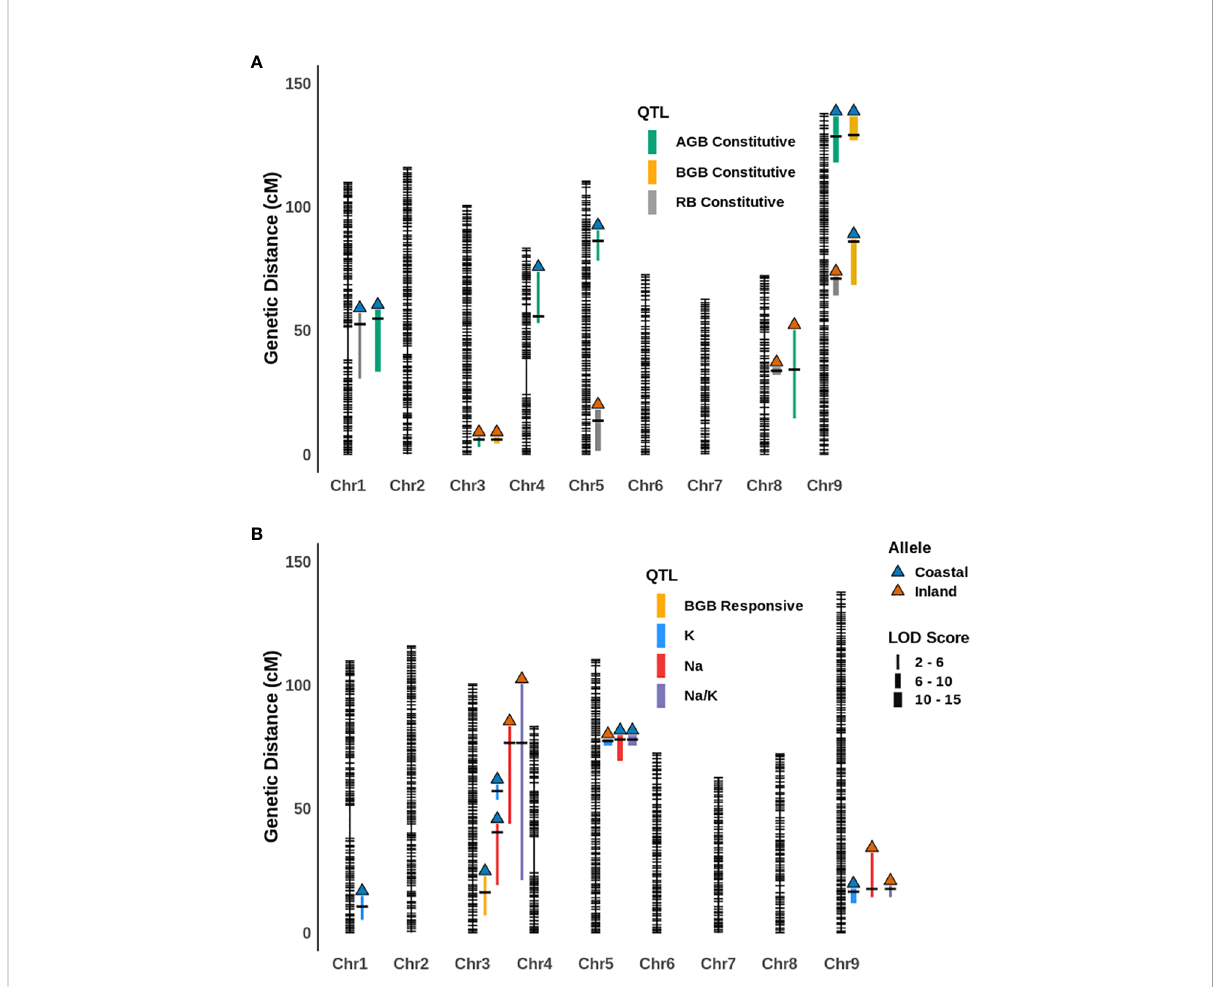
FIGURE 3 The position of (A) constitutive and (B) responsive category and ionic QTL for various traits on the genetic map of the P. hallii RIL population. Vertical color fi lled bar indicates QTL intervals estimated by 1.5 LOD drop from the peak. The width of the bar represents the magnitude of the LOD score for the given QTL and different colors represents different traits. The color of upward arrow indicates the genotype for alleles that have a positive effect for a given